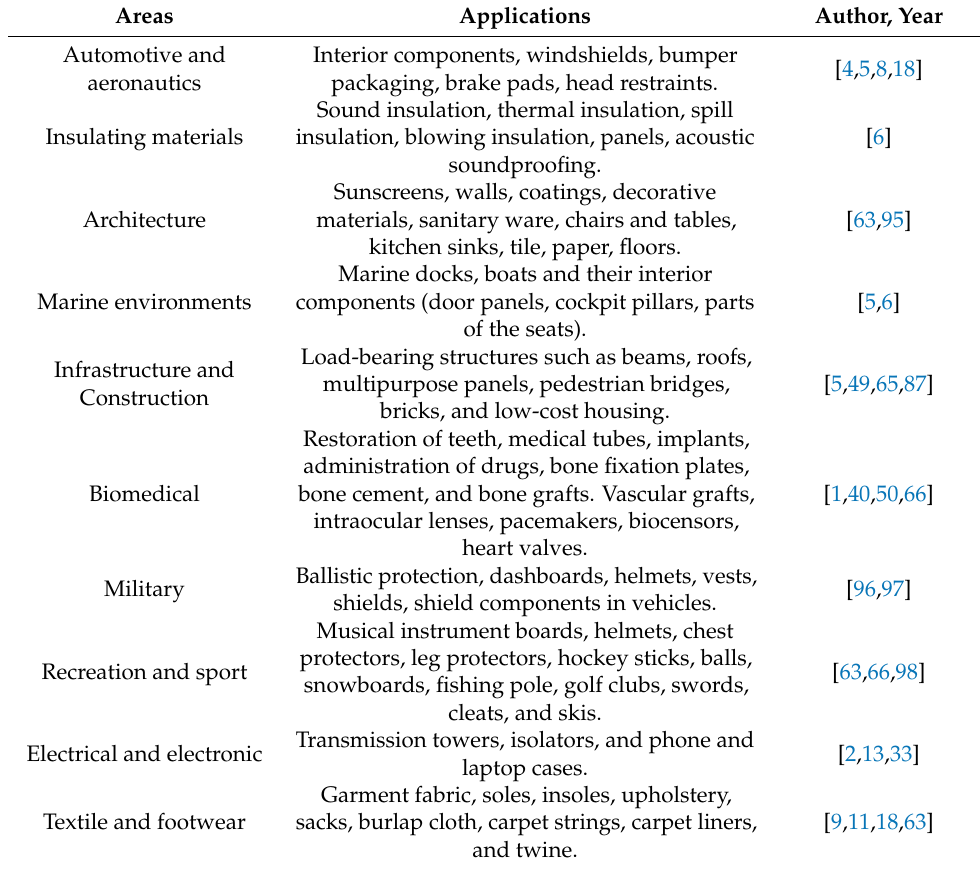
Table 5. Some applications of the polymeric matrix compounds reinforced with natural